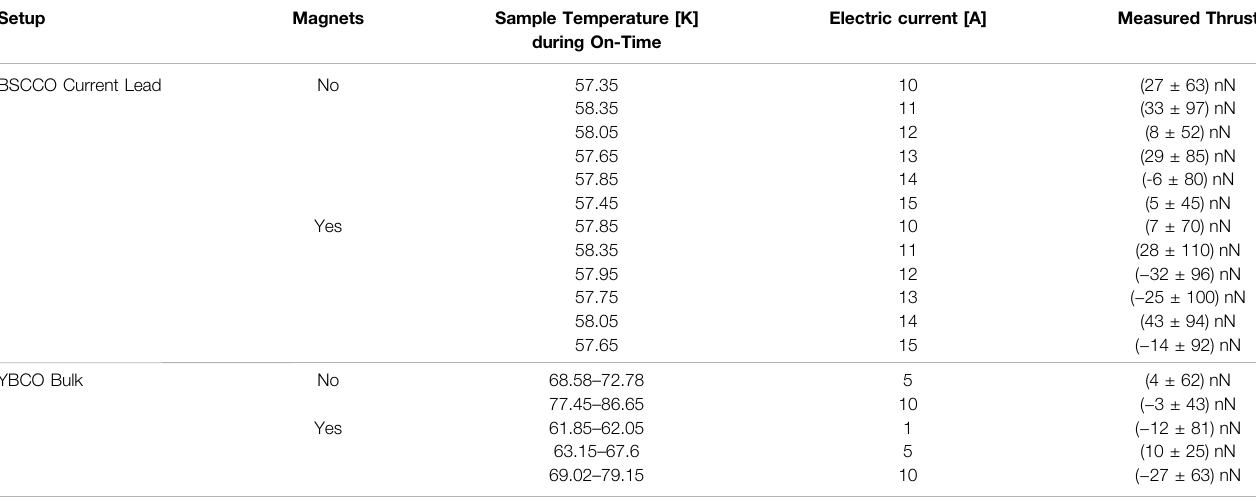
TABLE 1 | Summary of All Measurements (BSCCO sample temperature did not change during testing). Setup Magnets